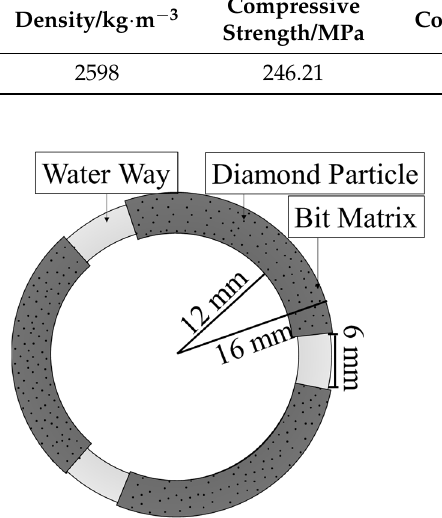
Figure 3. Drill bit.